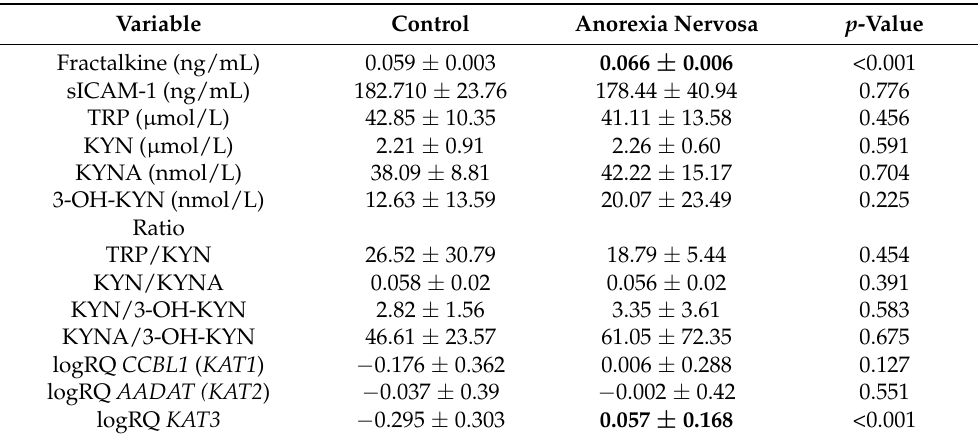
Table 2. Fractalkine, soluble intercellular adhesion molecule-1 (sICAM-1), tryptophan (TRP) metabo- lites and expression of kynurenine aminotransferases (KAT1-3) in anorexia nervosa. Variable Control